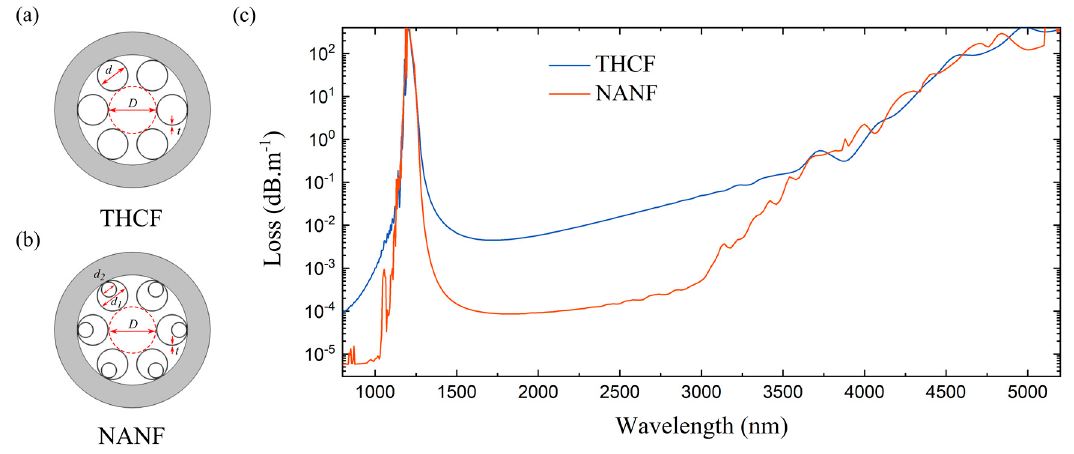
Figure 1. Idealized cross-sections of ( a ) a six-element tubular hollow-core fiber (THCF) and ( b ) a six-element nested antiresonant nodeless fiber (NANF). Gray shades correspond to the regions of dielectric medium, and white regions are hollow. D is the core diameter which is defined as the diameter of the largest circle that fits in the central hollow region. t is the dielectric wall thickness of the cladding elements. d is the exterior diameter of the cladding elements in THCF, and d 1 and d 2 are those of the outer and inner cladding tubes, respectively, in NANF. ( c ) Confinement loss of silica-based six-element THCF and NANF calculated using finite-element method. The structural parameters are D = 60 µ m, t = 0.6 µ m, and d = d 1 = 2 d 2 = 39 µm.